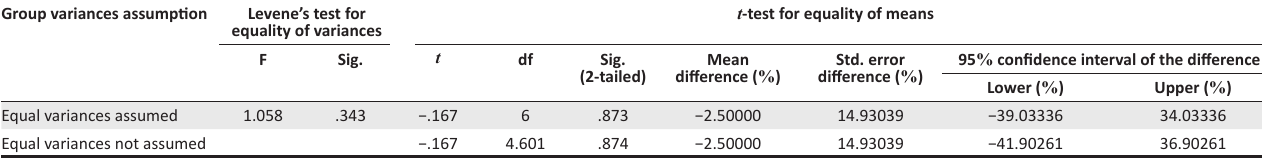
TABLE 2: Independent samples t -test for Pre-test One between the experimental and control groups. Group variances assumption